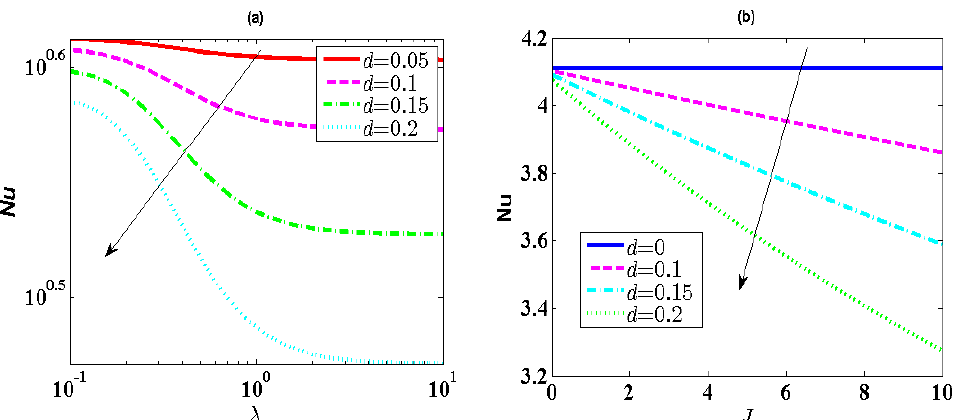
Figure 5. ( a ) The influence of d (0.05, 0.10, 0.15, 0.20) on Nu with λ (10 -1 –10) when K λ = 1, R = 1, α = 1, u r = 0.1, J = 5, Br = 0.01. ( b ) Influence of d (0, 0.10, 0.15, 0.20) on Nu with J (0–10) when λ = 0.25, K λ = 1, R = 1, α = 1, u r = 0.1, Br = 0.01.